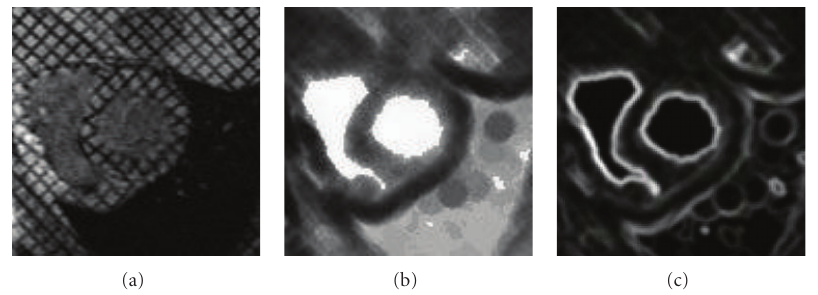
Figure 5: (a) Original image u 0 , (b) Computation of u endo